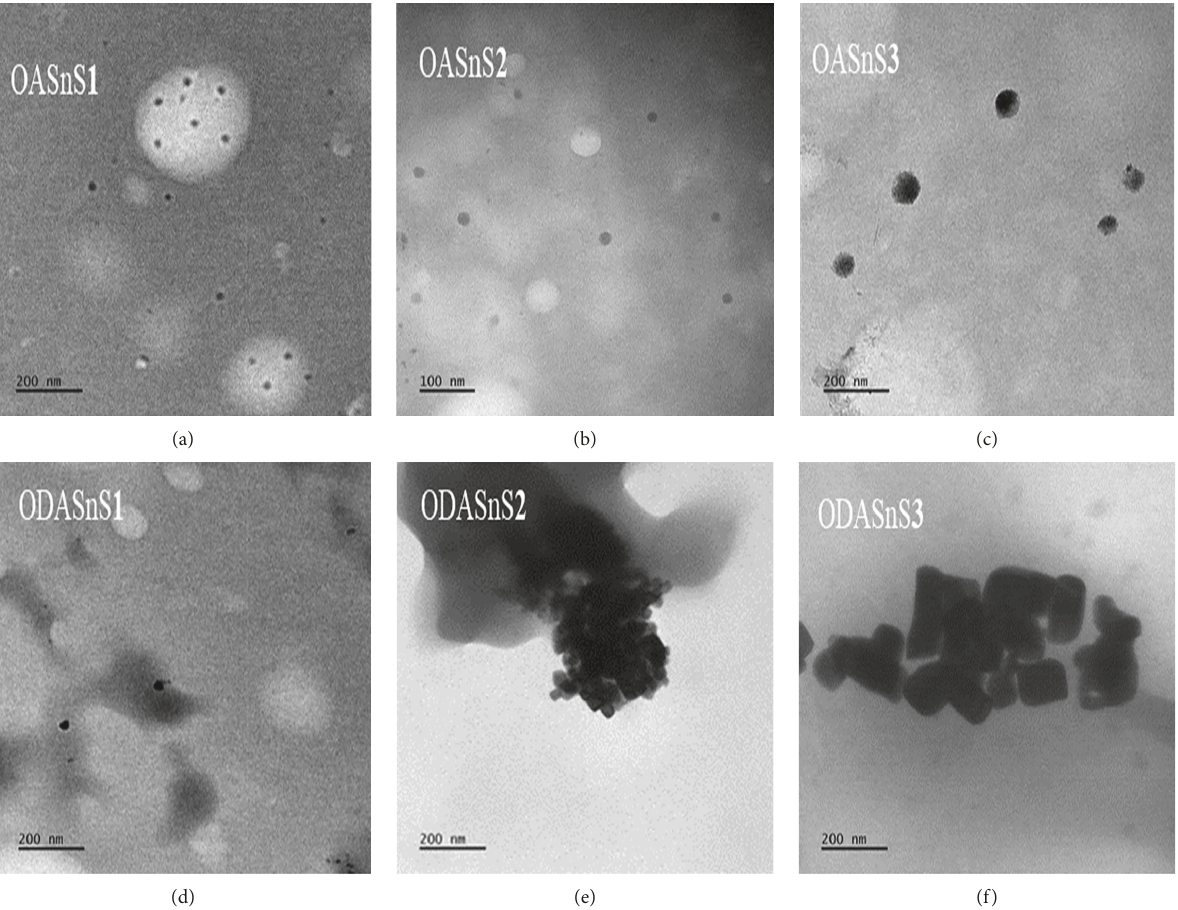
Figure 2: TEM images of OASnS1 (a), OASnS2 (b), and OASnS3 (c). TEM images of ODASnS1 (d), ODASnS2 (e), and ODASnS3 (f).